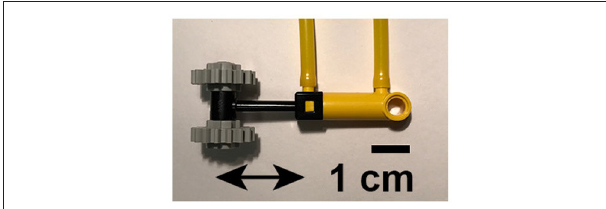
FIGURE 1 | Photograph of one of the eight pneumatic tactile stimulators used for somatosensory topographic mapping experiments. Arrows depict direction of travel of toothed wheels. Black line shows 1 cm